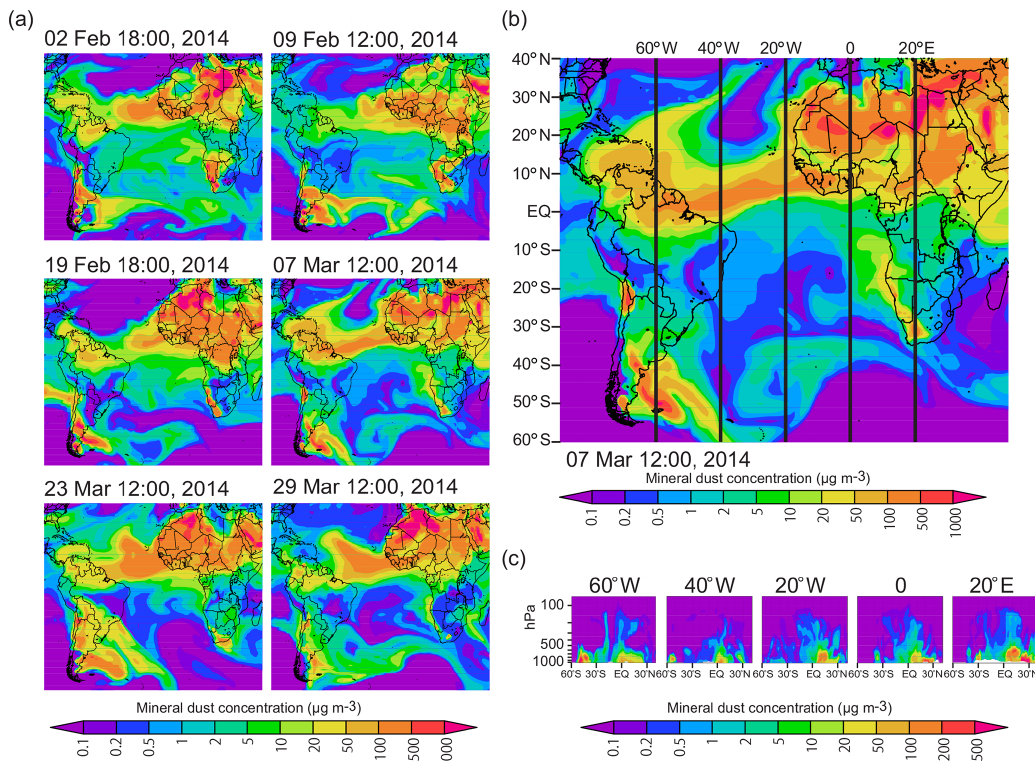
Figure 4. Model simulations of snapshots of (a) horizontal distributions of mineral dust concentrations at the surface level for each LRT period and (b) horizontal and (c) vertical distributions in a specific LRT event (7 March 2014). The sub-panels in (c) show the vertical distributions of mineral dust concentrations along the lines of longitude (black lines) in (b) . All times given in Fig. 4 are in coordinated universal time